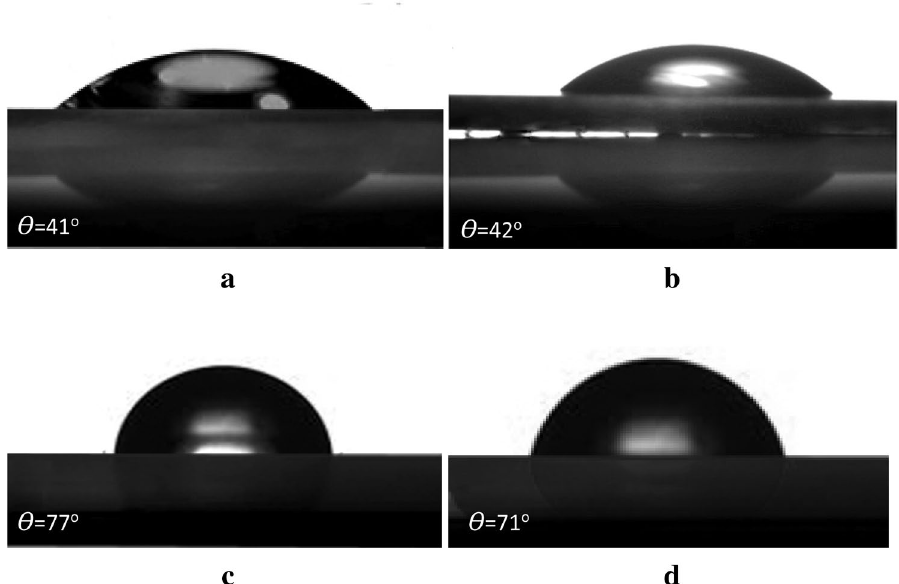
Figure 3. The water contact angle of the fabricated membranes: ( a ) top surface of SAN membrane, ( b ) top surface of PAN membrane, ( c ) bottom surface of SAN membrane, ( d ) top surface of PS membrane. As can be seen from ( a ) and ( b ), the top surface contact angle of SAN membrane (42°) is similar to the water contact angle of PAN (41°); furthermore, the bottom surface contact angle of the SAN membrane (71°) is similar to the water contact angle of PS (77°). It should be noted that the DMF was used as a solvent and the polymer concentration was 8% w/w; also, the membranes were fabricated under the same conditions as 300 s BWB time at a bath temperature of 0 °C and 250 µm of the polymeric film